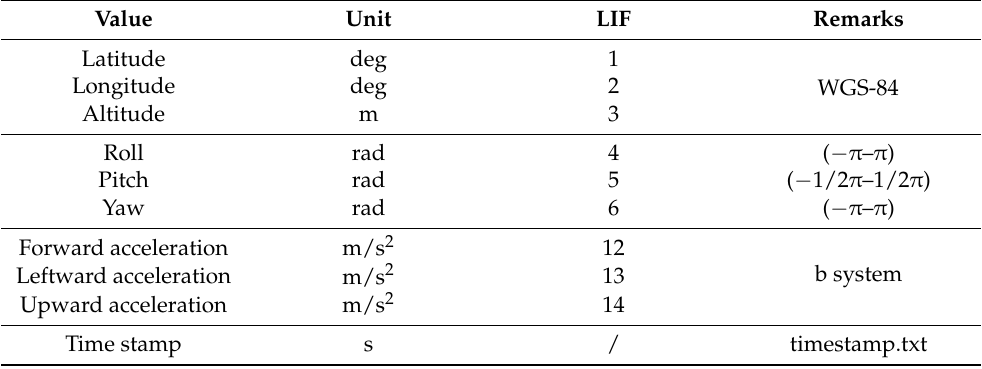
Table 1. Attribute related to values used. LIF means the list of the value in the